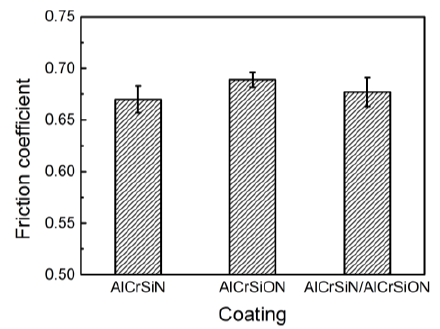
Figure 9. Average friction coefficients of the AlCrSiN coating, AlCrSiON coating, and AlCrSiN/AlCrSiON duplex coating.